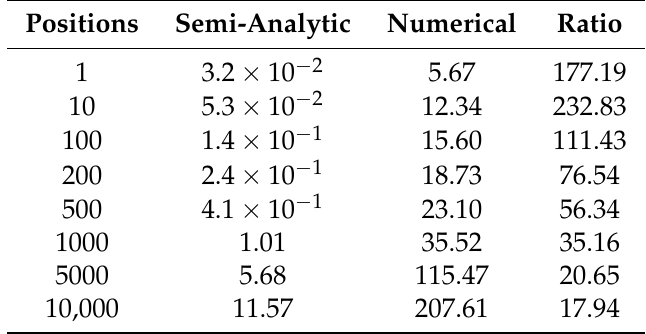
Figure 15. Model problem 2. Average time (in seconds) to solve for one tool position as the number of time(seconds) tool positions varies ( positions). number of tool Table 1. A time comparison (in seconds) for a vertical well using a semi-analytic method and the proposed multi-scale FEM as a function of the number of tool